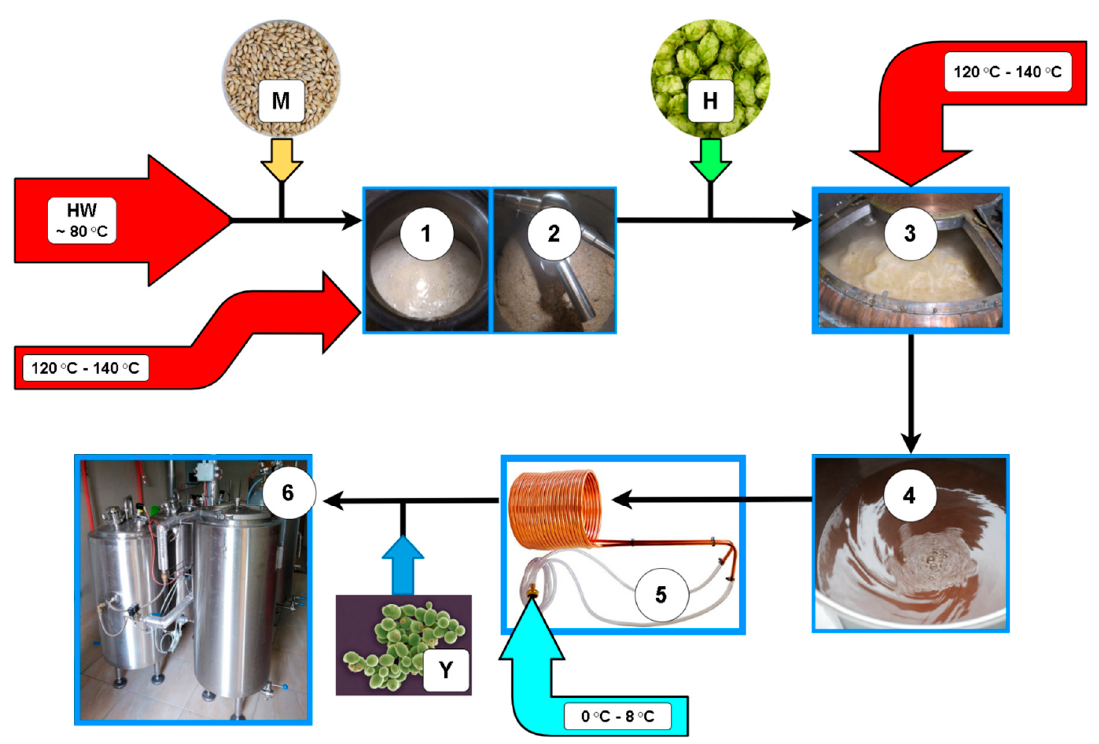
Figure 1. Pilot-scale installation diagram, with special emphasis on unit operations with heat / cold demand. Heat supply marked with red arrows, cold supply marked with a cyan arrow (1–mashing; 2–lautering; 3–boiling; 4–wort separation in a whirlpool; 5–wort cooling; 6–fermentation; M–malt; H–hops; Y - yeasts).